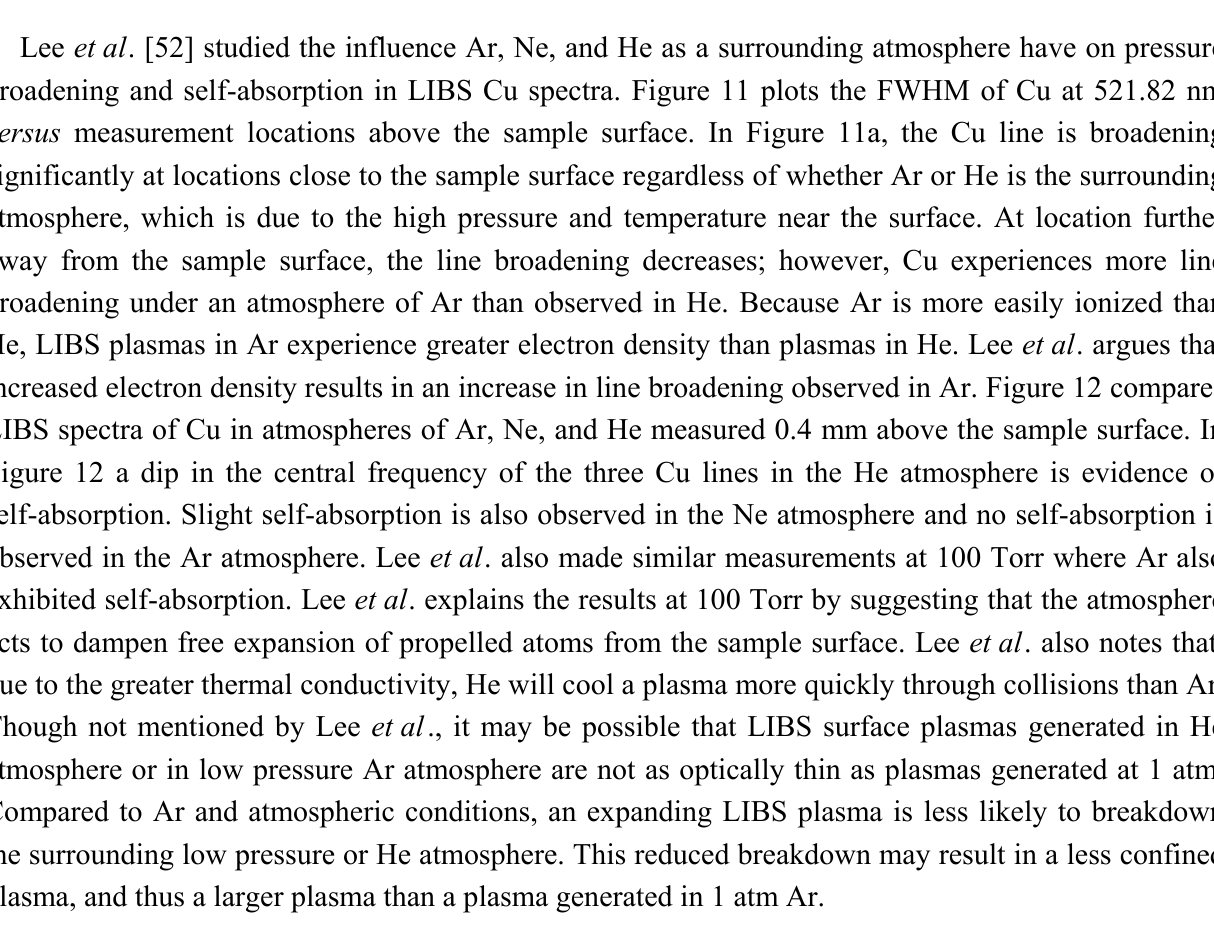
Figure 11. Full width at half-maximum of copper line at 521.82 from LIBS versus emission collection from sample surface. Reprinted from reference